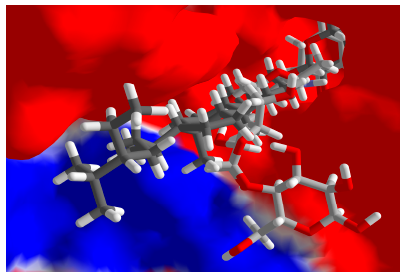
Figure 3. Lowest-energy docked pose of daucosterol (dark grey stick figure) with human maltase-glucoamylase (PDB 3TOP), showing the electrostatic surface of the binding site. The co-crystallized ligand, α -acarbose, is shown as a light grey stick figure.